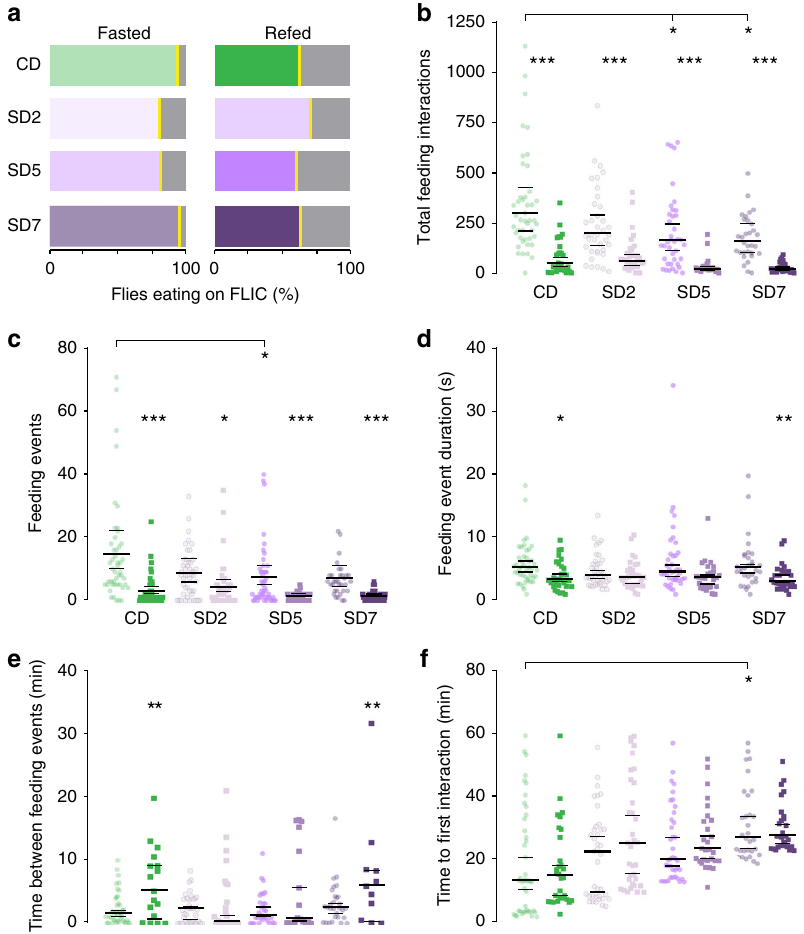
Fig. 5 SD changes the magnitude of the behavioral responses to fasting. The feeding behavior of 24 h-fasted (lighter shades) and previously refed (darker shades) fl ies during ad-libitum access to 5% sucrose on the FLIC for 1 h. Control diet, CD (green shade) and high sugar diet day 2, 5, and 7 (SD2, SD5,